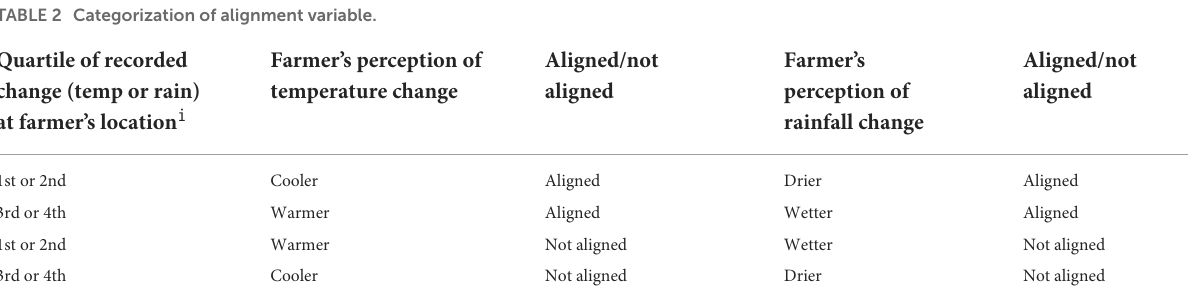
TABLE 2 Categorization of alignment